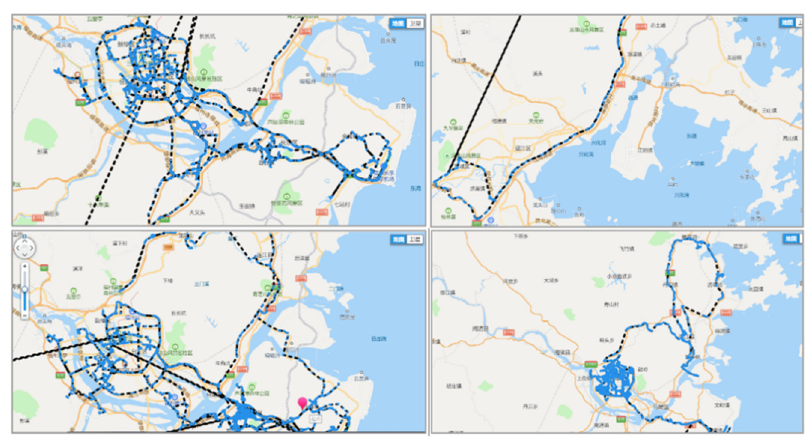
Figure 7. Captured track information display.